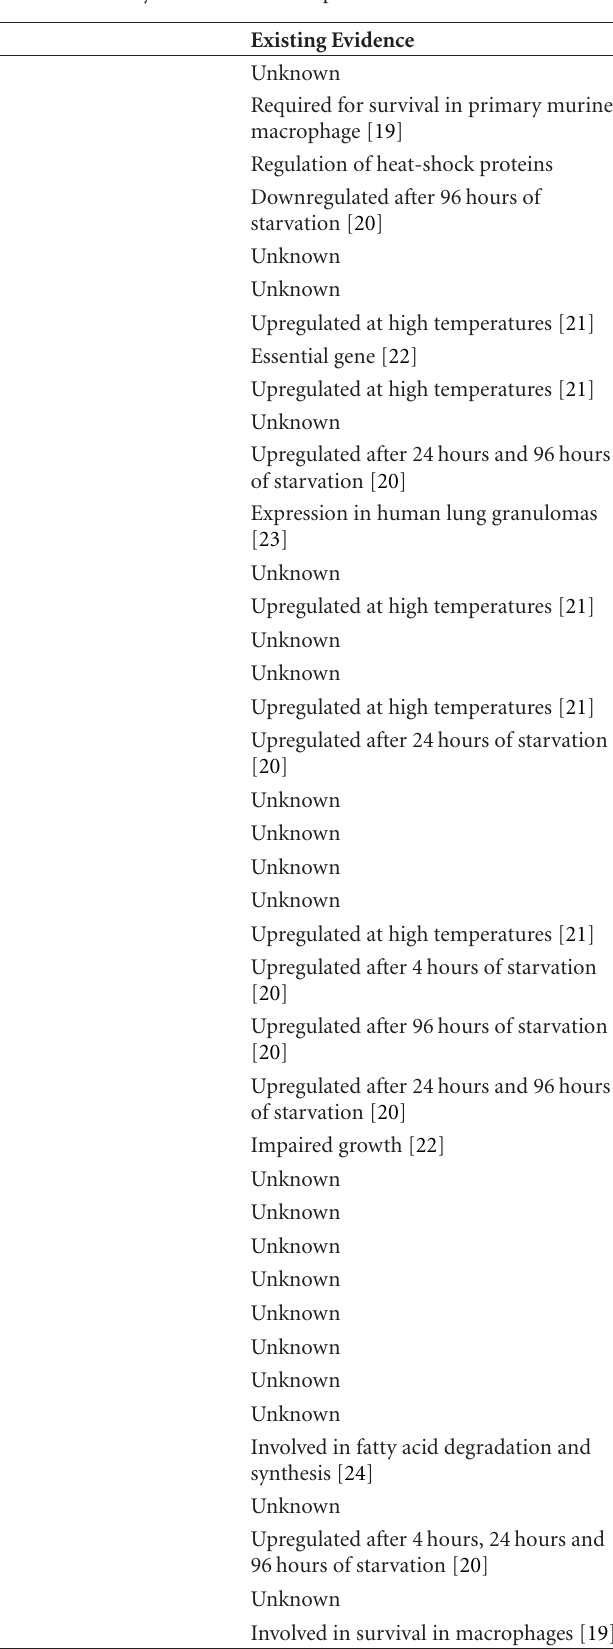
Table 4: Current evidence linking genes identified in this study to M. tuberculosis